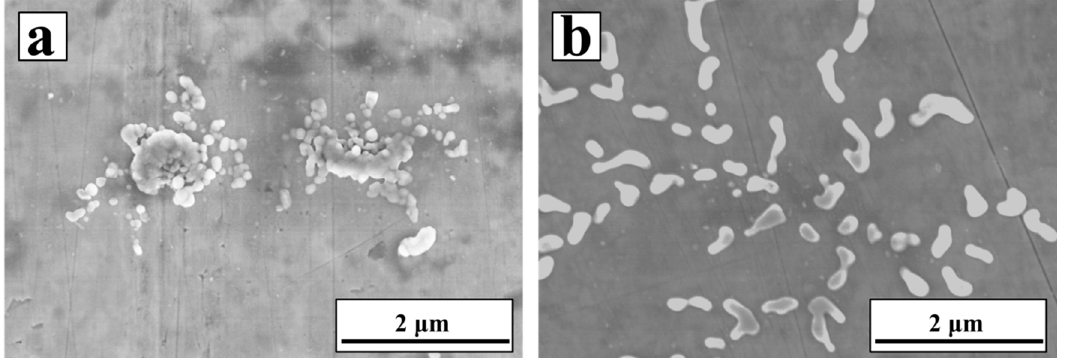
Figure 6. SEM images of the casted steels with different particles ( a ) 0.15 wt % NbC and ( b ) 0.15 wt % NbC in the form of NbC–Fe.